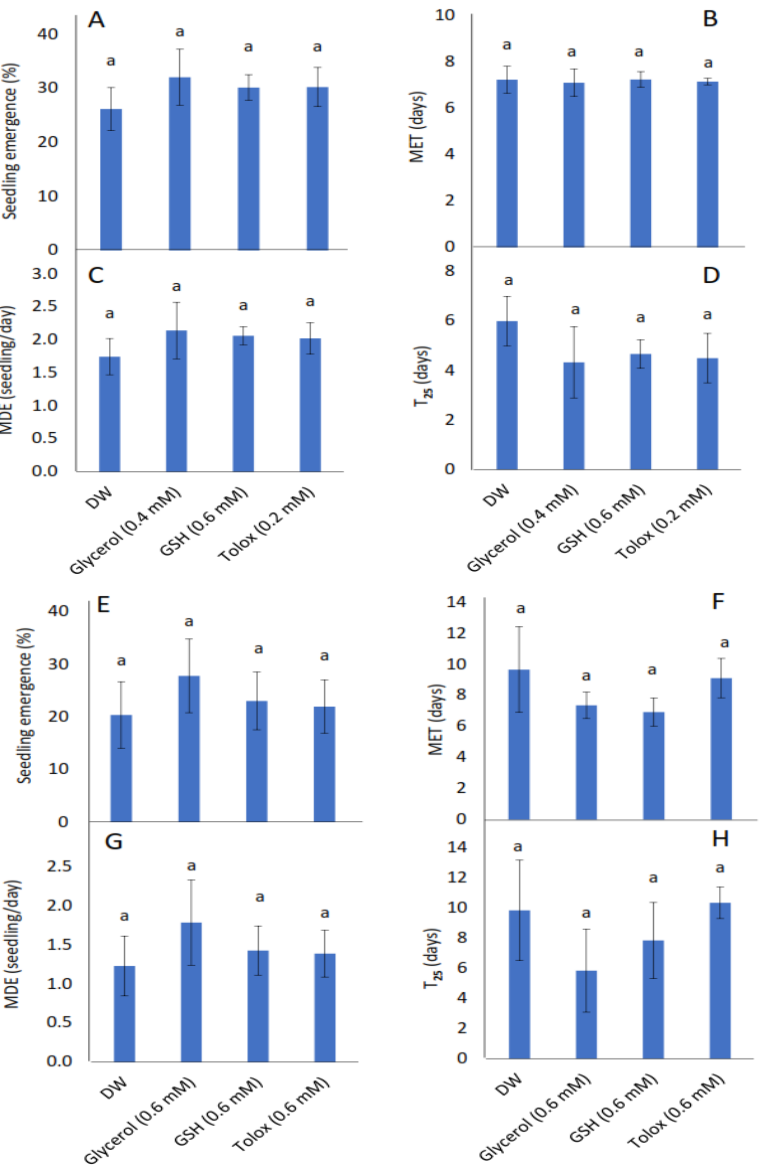
Figure 2. Effect of exogenous application of antioxidants on seedling emergence parameters: % seedling emergence ( A , E ), mean emergence time (MET) ( B , F ), mean daily emergence (MDE) ( C , G ), and time taken to 25% emergence (T 25 ) ( D , H ) from P25 seeds of cabbage ( B . oleracea ) ( A – D ) and lettuce ( L . sativa ) ( E – H ) subjected to soaking in deionised water (DW), glycerol, glutathione (GSH) or trolox. Values represent mean ± SD (3 × n = 60). Bars labelled with the same letters indicate no significant differences across the control (DW) and antioxidant treatments for all four parameters ( p < 0.05, ANOVA).